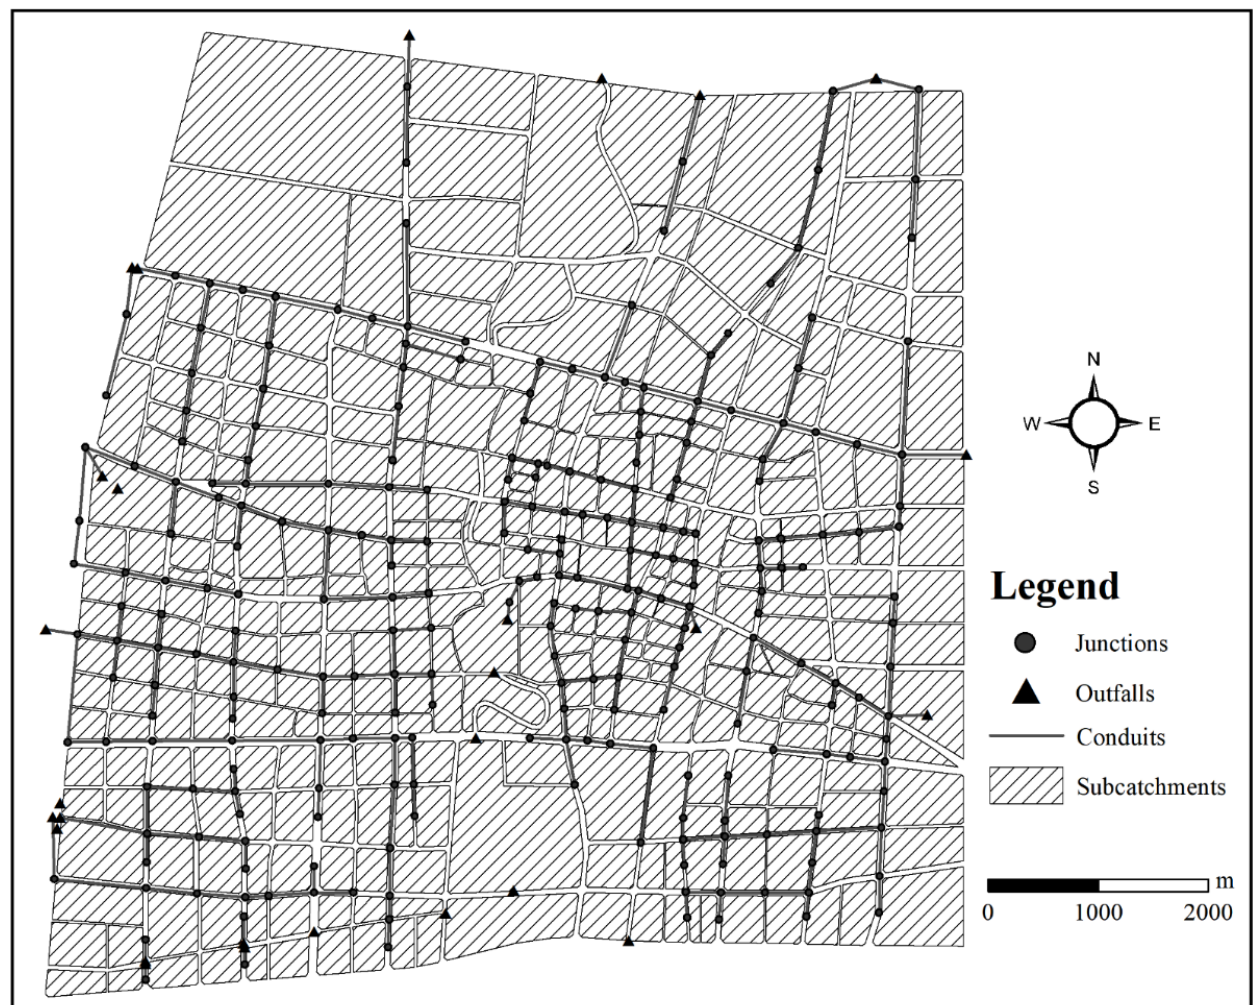
Figure 4. Generalization results of the SWMM model and the topological relationship of the pipeline.